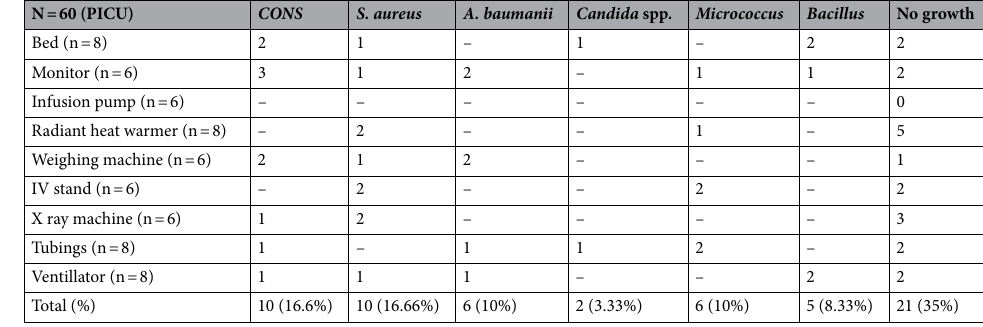
Table 1. Spectrum of micro-organism isolated from medical devices associated infection in PICU. Different organisms isolated from different instruments of PICU. The organisms which were isolated are CoNS (10),